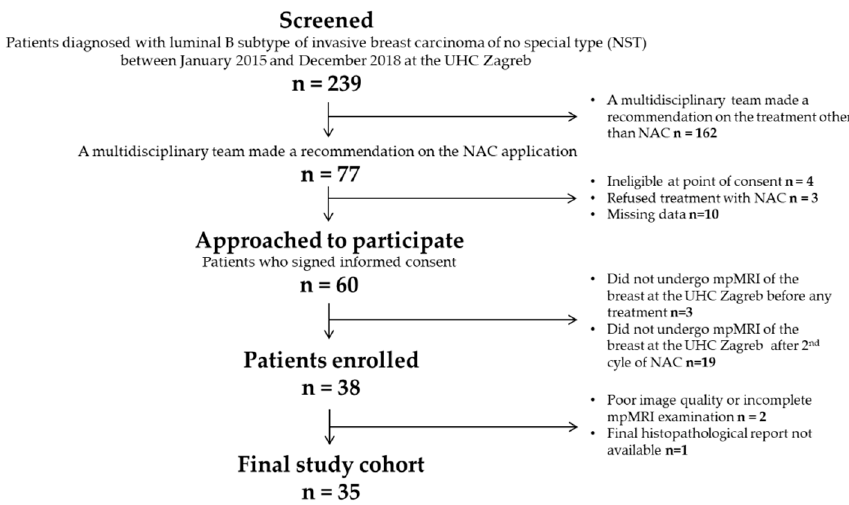
Figure 1. Flow chart of the patient selection process.